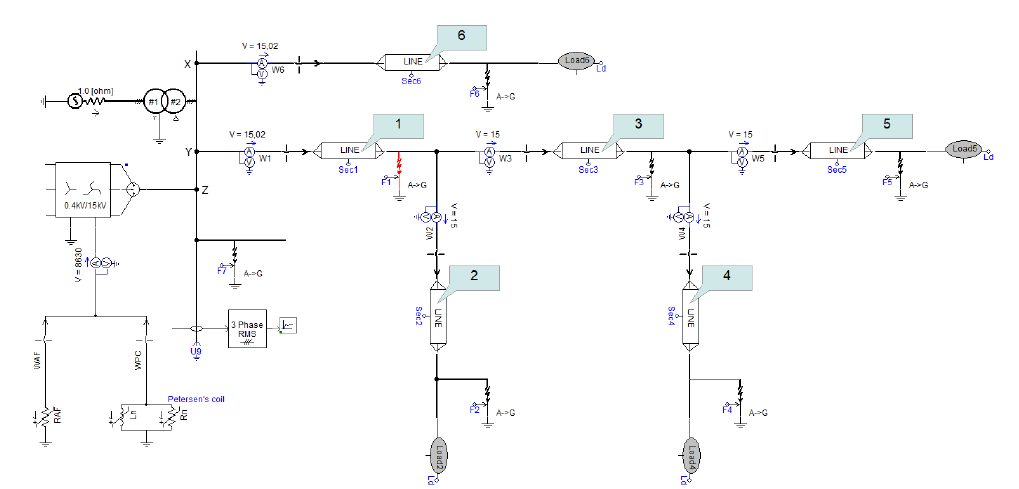
Figure 10. MV network model used to test new earth fault detection methods by